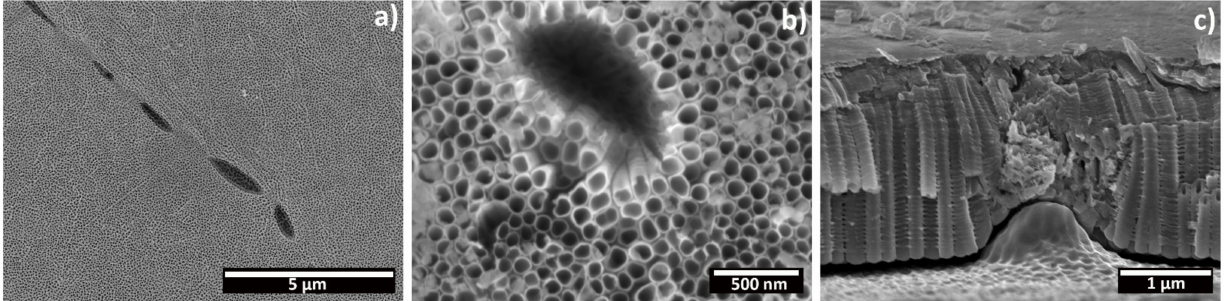
Figure 7. FESEM micrographs of the cavities in the anodic oxide: ( a ) top surface morphology at a low magnification, ( b ) detail of a cavity in the top morphology, and ( c ) a cross-section view. Higher-magnification micrographs of the nanotubes’ top surfaces are reported